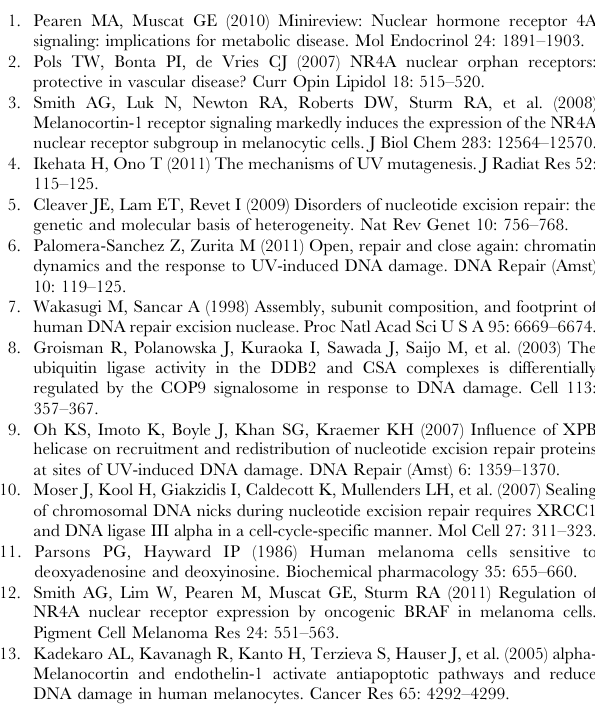
data are representative images from 4 independent experiments. Left panels (green fluorescence), pEYFP-NR4A2-N2-DS; Middle panels, c H2A.X, DB2 or XPC immunofluorescence (red); Right panels, merged images; Representative images from 4 independent experiments is shown. Figure S3 Trichostatin A (TSA) treatment restores the transcriptional activity of NR4A2- D H12. (A) Schematic representation of pNBRE-tk_LUC transiently transfected into COS-1 cells with WT or D H12 mutant form of NR4A2. (B) Transcriptional activity of empty pEYFP vector, pEYFP-NR4A2- WT and pEYFP-NR4A2- D H12 in the presence of Vehicle or TSA. Each data point represents the mean 6 SEM of results from 3 independent experiments. Statistical analysis was performed using One-way ANOVA with a Tukey’s post-test (**, p , 0.001; *, p , 0.01; ns, not